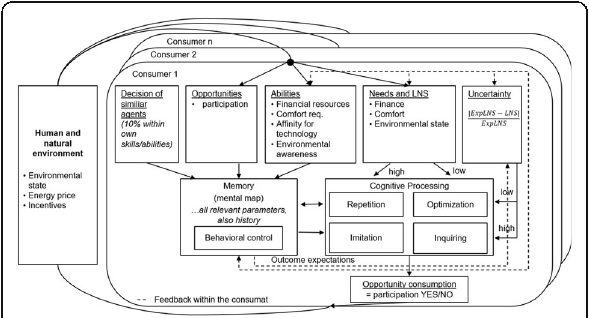
Fig. 1 (Research). Conceptual demand response consumer model based on